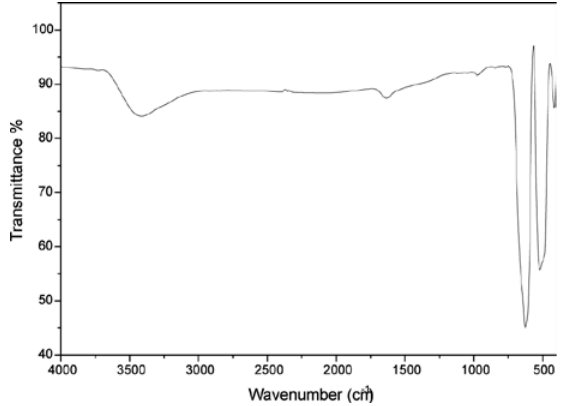
Figure 2. FTIR spectra of as-synthesized Mn